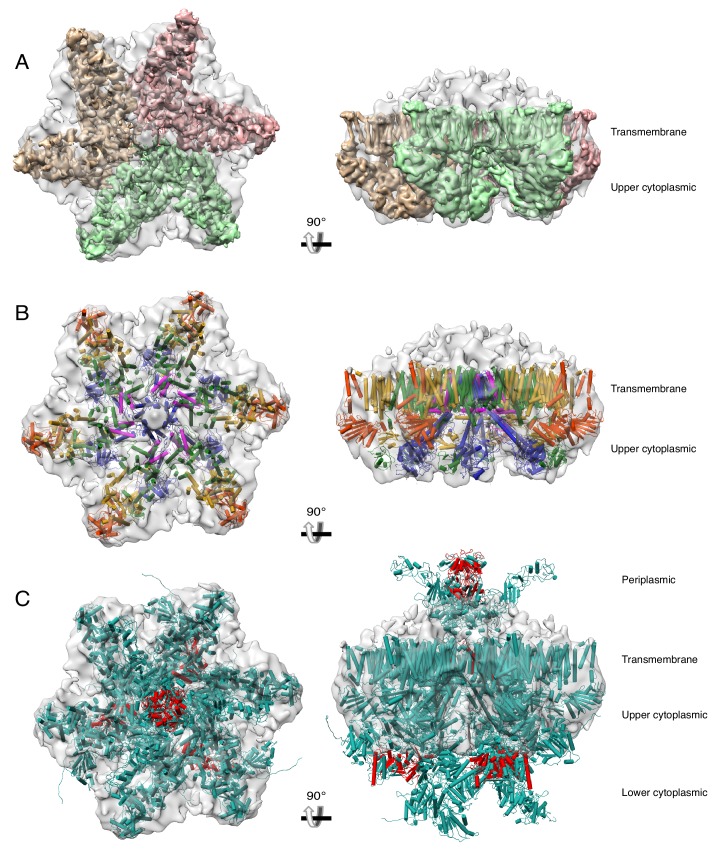
A hexameric model of the ESX-3 dimer.(A) Fit of three copies of the transmembrane and upper cytoplasmic regions of the ESX-3 translocon complex into the ESX-5 hexameric structure (EMDB 3596). The ESX-3 translocon complex was filtered to 6 Å resolution to permit easy visualization of the EccC3 transmembrane helices. (B) The model of the ESX-3 translocon complex for the full transmembrane and upper cytoplasmic domains (including homology models of the EccC3 transmembrane helices accurate to 6 Å resolution) colored by protein. (C) The full model of the ESX-3 translocon complex including homology models for all three EccC3 ATPase domains and the periplasmic domain of EccB3 docked into the ESX-5 negative stain map. Red represents areas were atoms clash substantially.